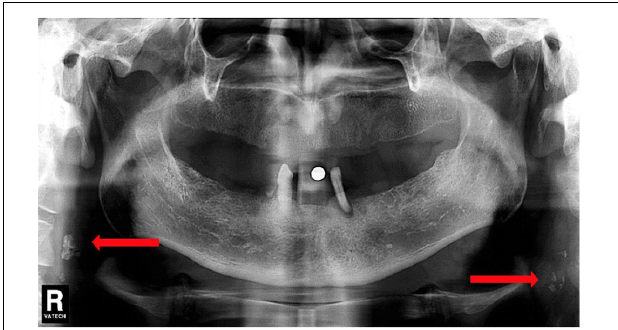
FIGURE 5 | Dental Pantomogram (DPT) in which arrows indicate carotid artery calcifications. Reproduced from Ribeiro et al. (2018). Copyright© 2018 Elsevier Masson SAS. All rights